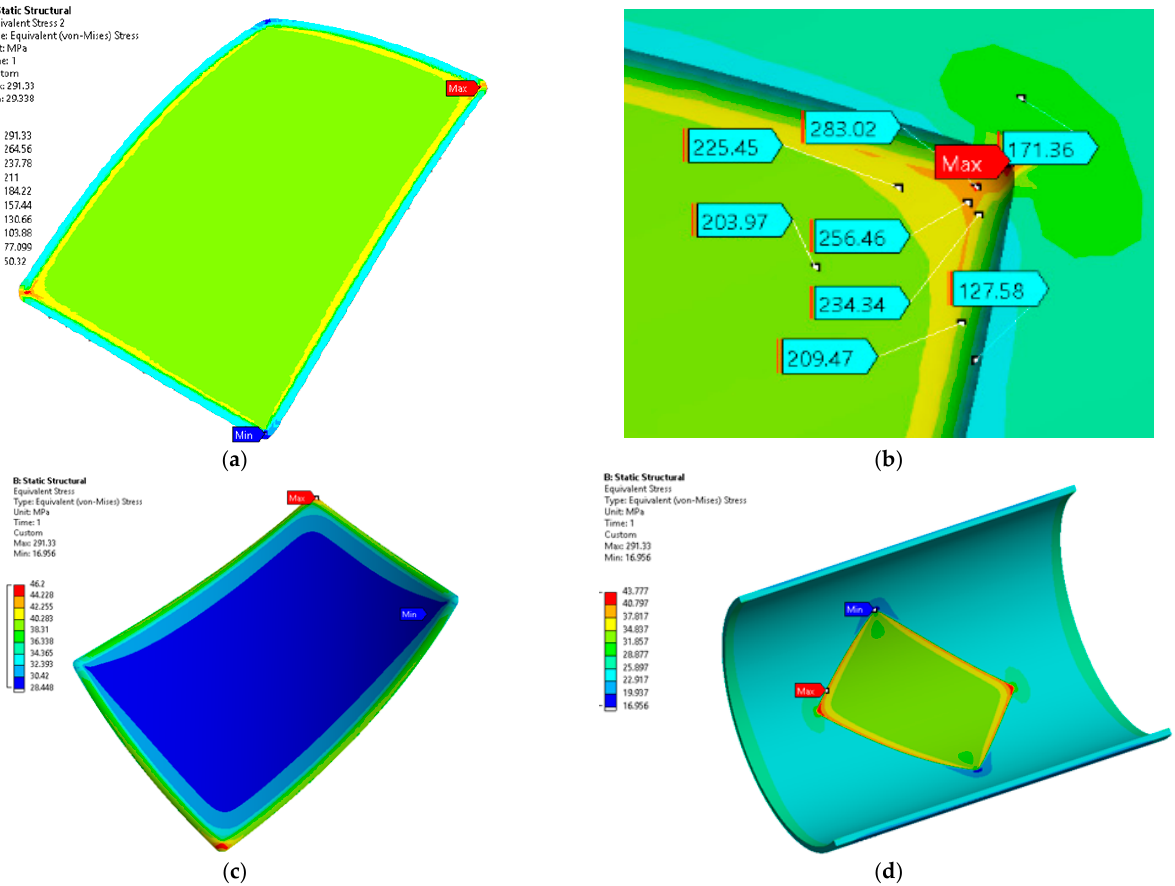
Figure 10. Equivalent Von Mises stress distribution: ( a ). steel pipe (defect area); steel pipe (defect corner – detail); ( b , c ). filler; ( d ). composite wrap. ( D e = 323.9 mm, d rd = 0.3, α = 45 degrees).